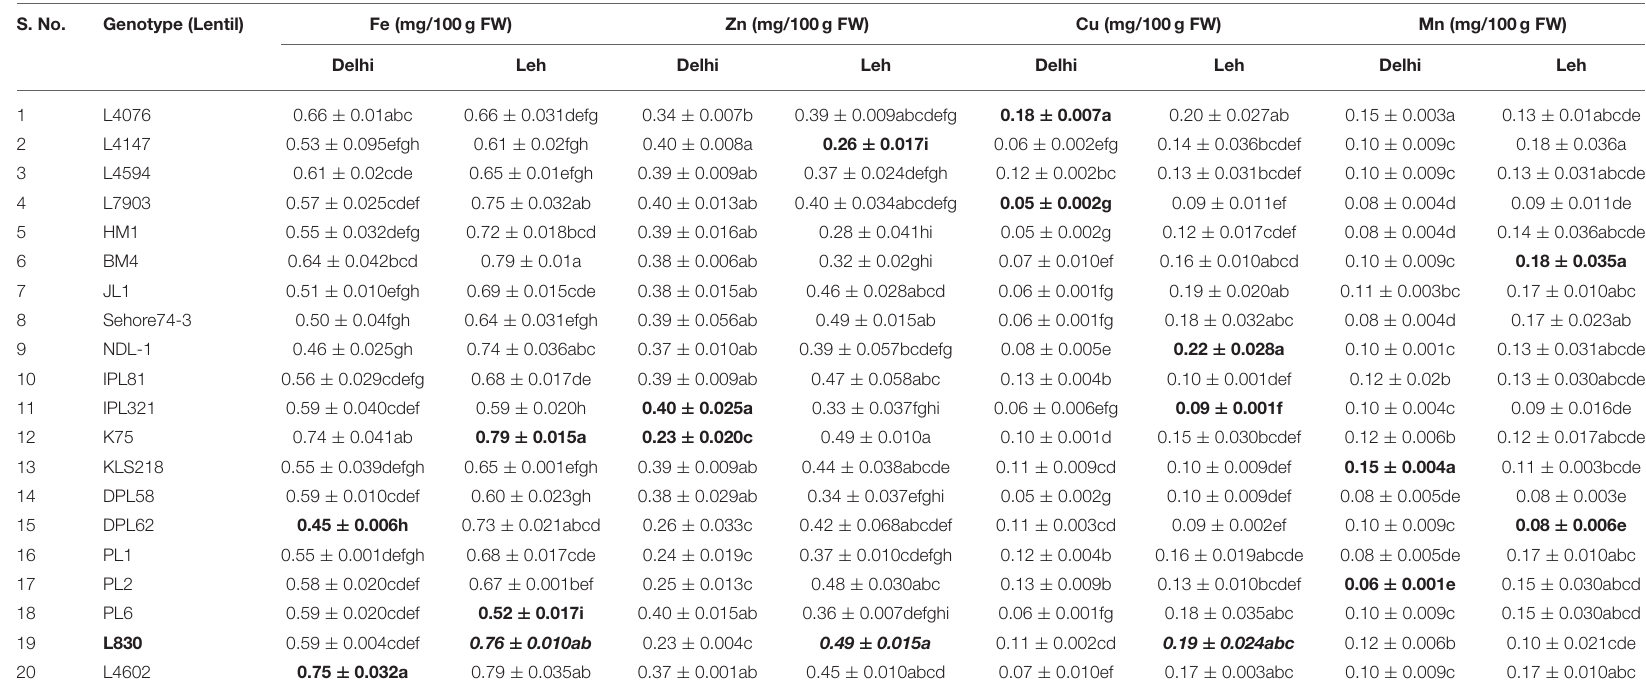
Values are expressed as mean ± SD (n = 3), and different letters indicate a significant difference (p ≤